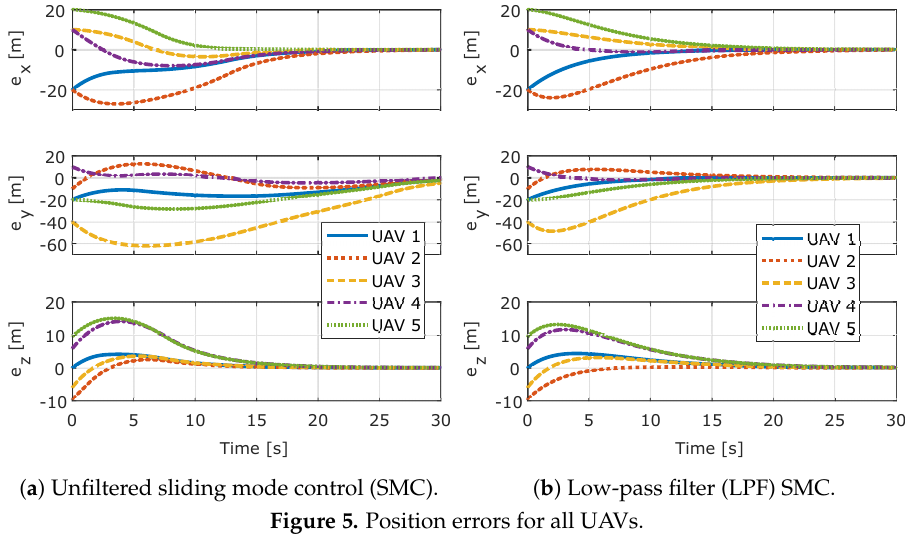
Figure 5. Position errors for all UAVs.